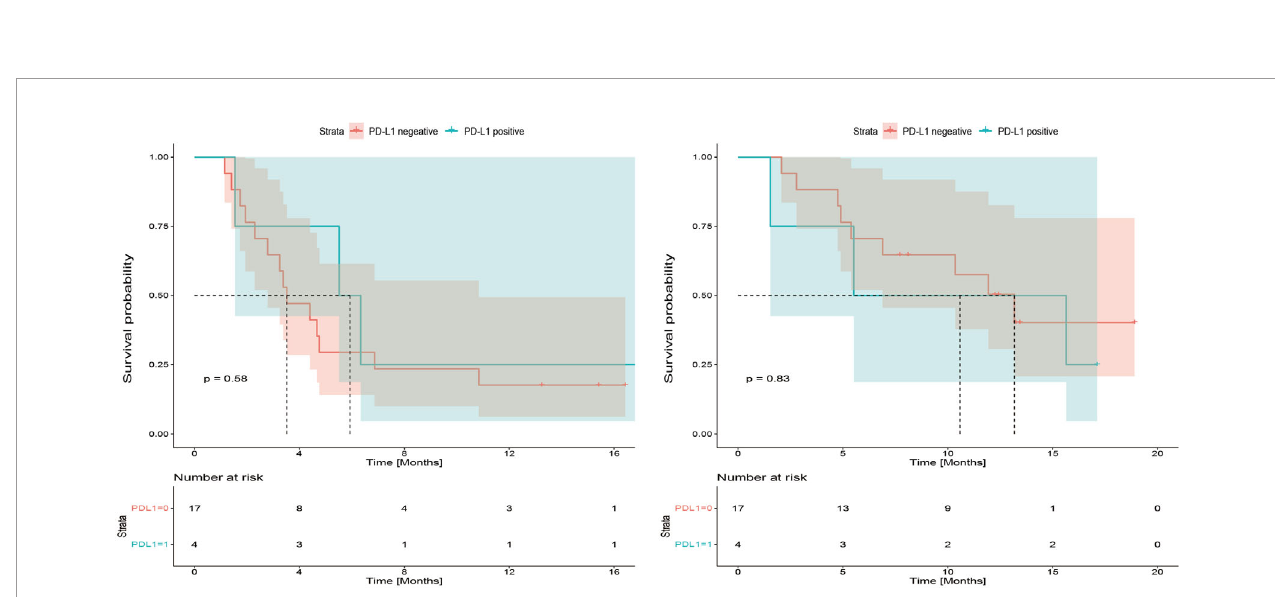
FIGURE 4 | Kaplan-Meier plot for progression-free survival (PFS) and overall survival (OS) based on programmed cell death 1 ligand-1 (PD-L1) immunohistochemical